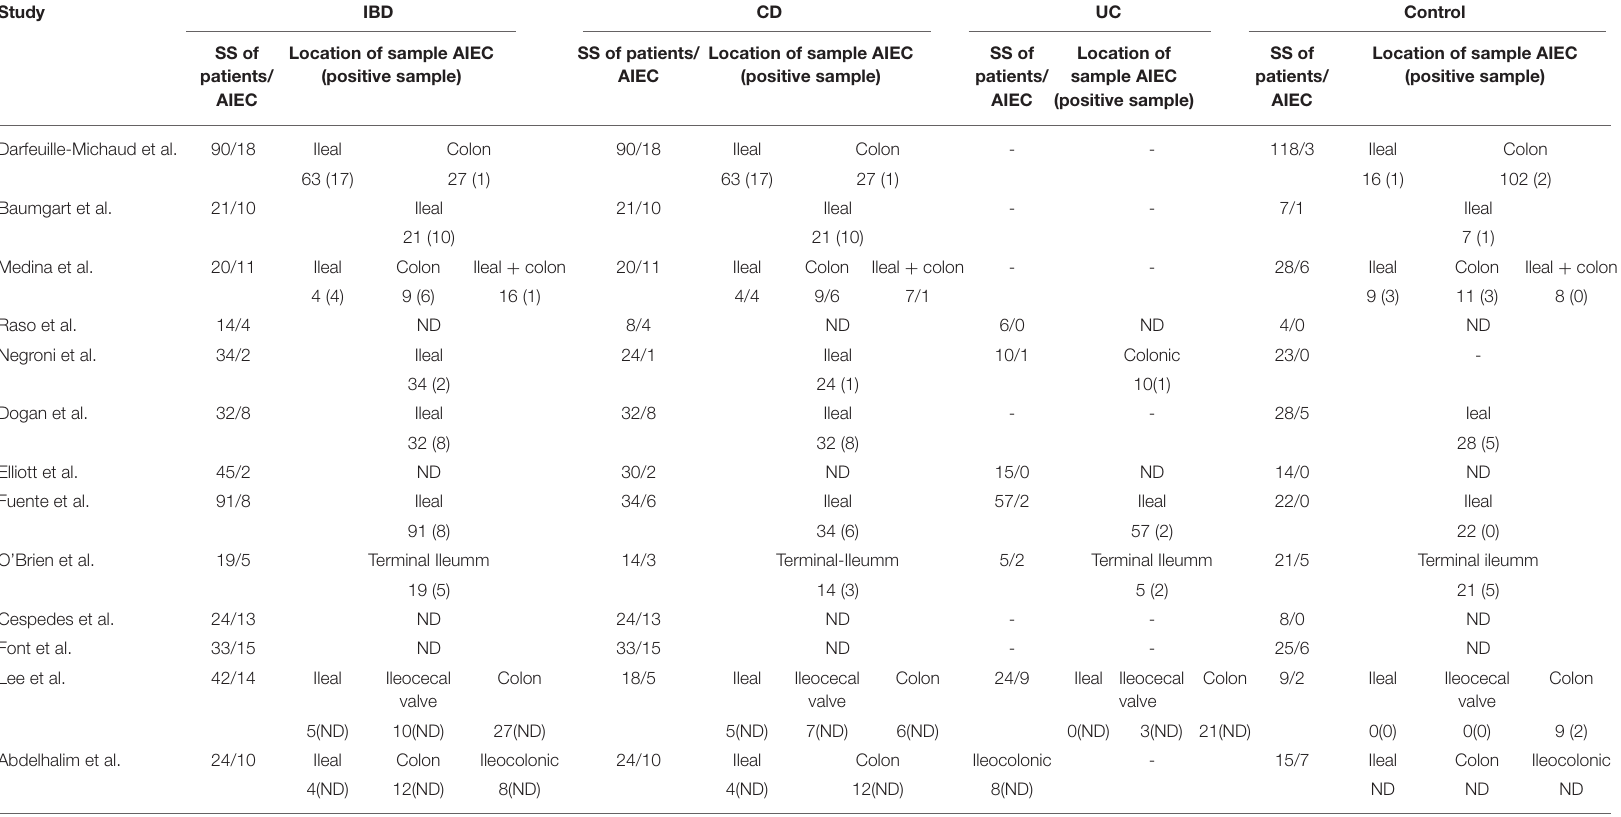
24/10 Ileal Colon Ileocolonic - 15/7 Ileal Colon Ileocolonic 4(ND) 12(ND) 8(ND) 4(ND) 12(ND) 8(ND) ND ND